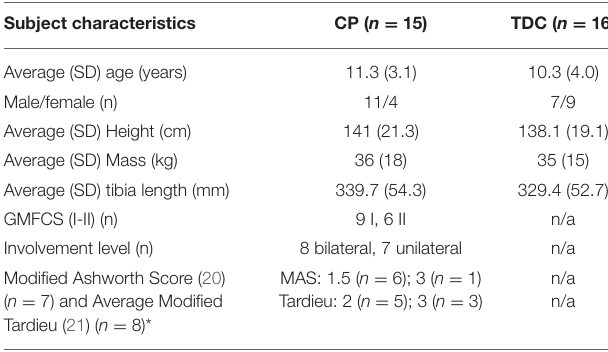
TABLE 1 | Subject characteristics in children with cerebral palsy (CP) and typically developing children